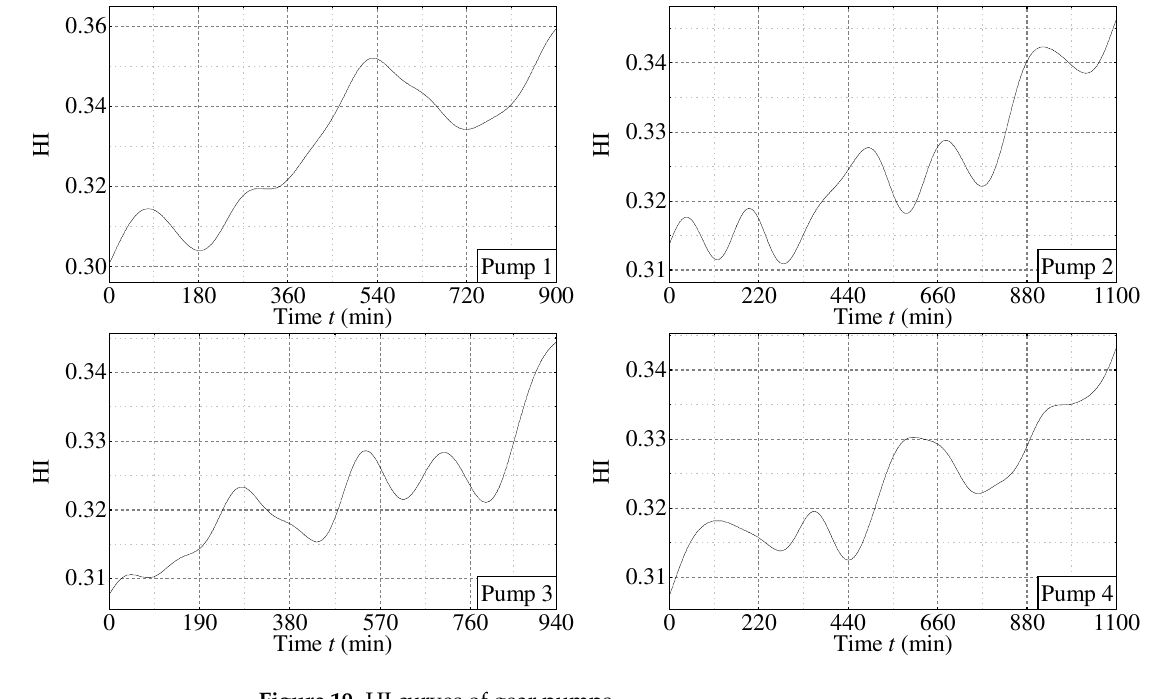
Figure 19. HI curves of gear pumps.